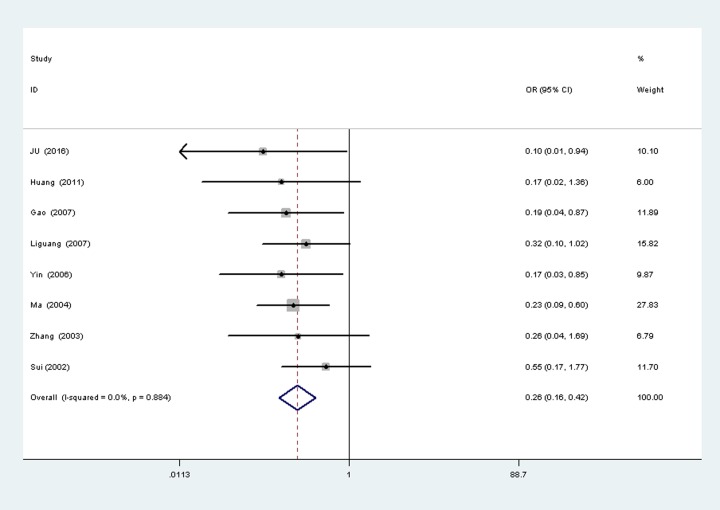
Tumor FIGO stage.